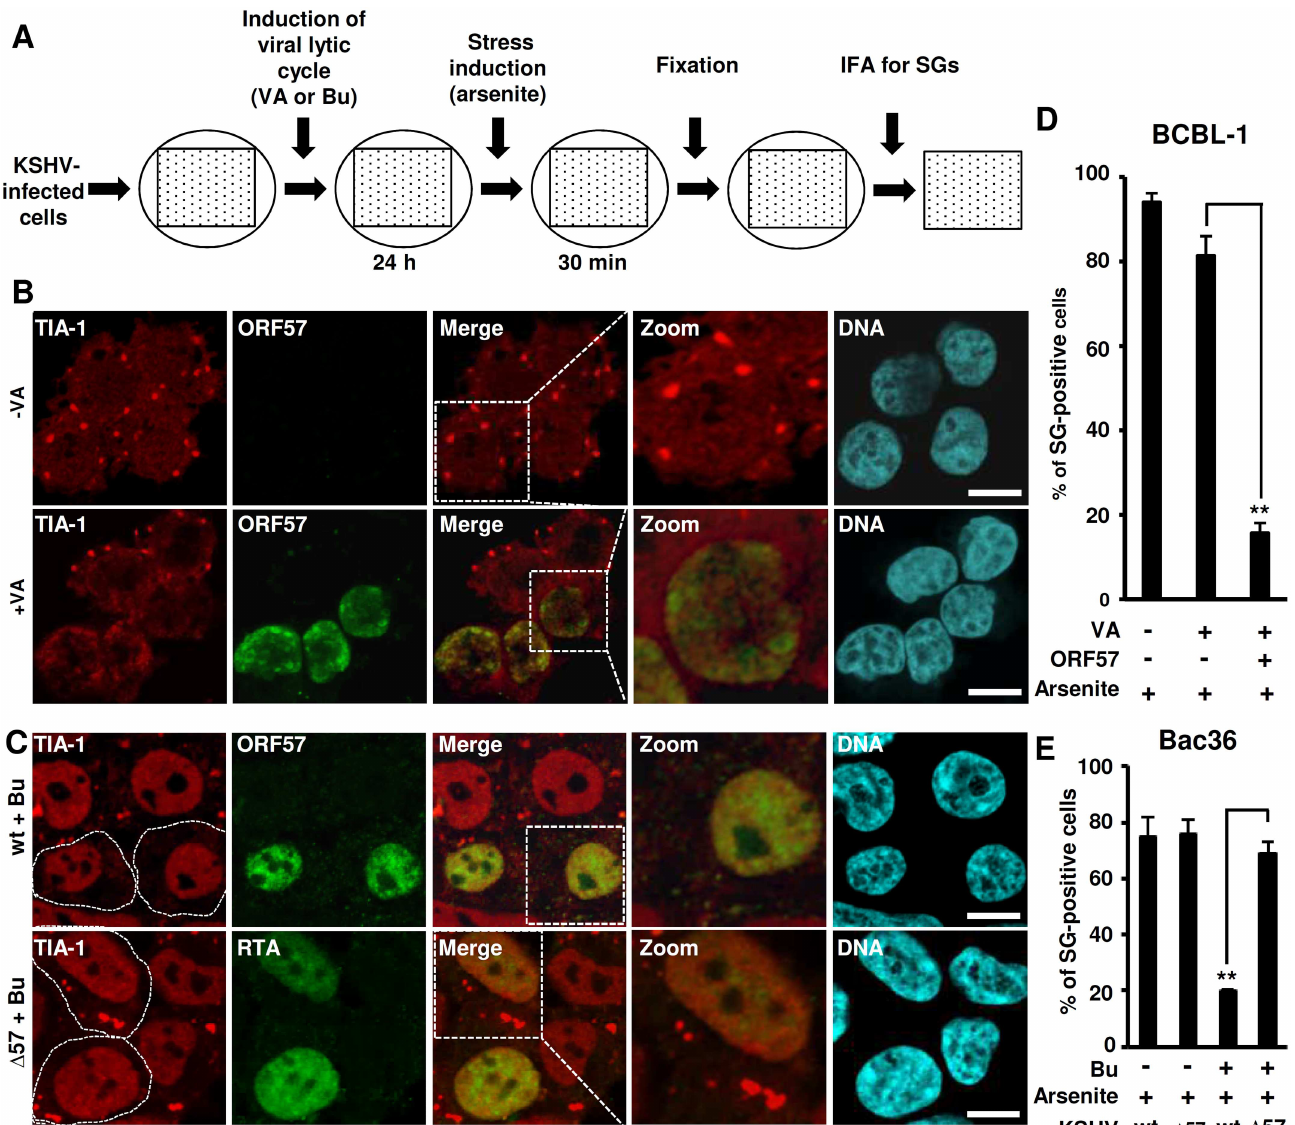
Fig 1. KSHV latent infection is permissivefor SG formation while the viral lytic infection with ORF57 expression is refractory. (A) Outlines of KSHV reactivation and stress granuleinductionin BCBL-1 or Bac36 cells. Circles, culture dishes; dotted squares, cells grown on cover slips. (B and C) Induction of SG by arsenite in KSHV-infected BCBL-1 and Bac36 cells. KSHV lytic infection in BCBL-1 was inducedby valproic acid (VA, 1 mM) (B) and in Bac36 cells harboringa wild-type or ORF57-null KSHV genome(wt or Δ 57) was inducedby sodium butyrate (Bu, 3 mM) (C). The cells with or without VA or Bu inductionfor 24 h were further treated with 0.5 mM arsenitefor 30 min and then immunostained for the SG-specific marker TIA-1 and viral lytic protein ORF57 (BCBL-1 cells and Bac36 wt cells) or RTA (Bac36 Δ 57 cells). Bac36 cells with ORF57 or RTA expression(C) are separated from the cells without ORF57 or RTA expressionby dashed white borderlines. The nucleiwere counterstained with Hoechst dye. Scale bar = 10 μ m. (D and E) Proportionof BCBL-1 and Bac36 cells with SG formation before and after virus lytic reactivation. Total of 50 cells in each group, ORF57-positive or RTA-positive (for Δ 57 Bac36 cells) cells vs ORF57-negative or RTA-negative (for Δ 57 Bac36 cells) cells, were countedin each experiment. The error bars represent SD from three independentexperiments. ** P < 0.01in Chi-squared test.